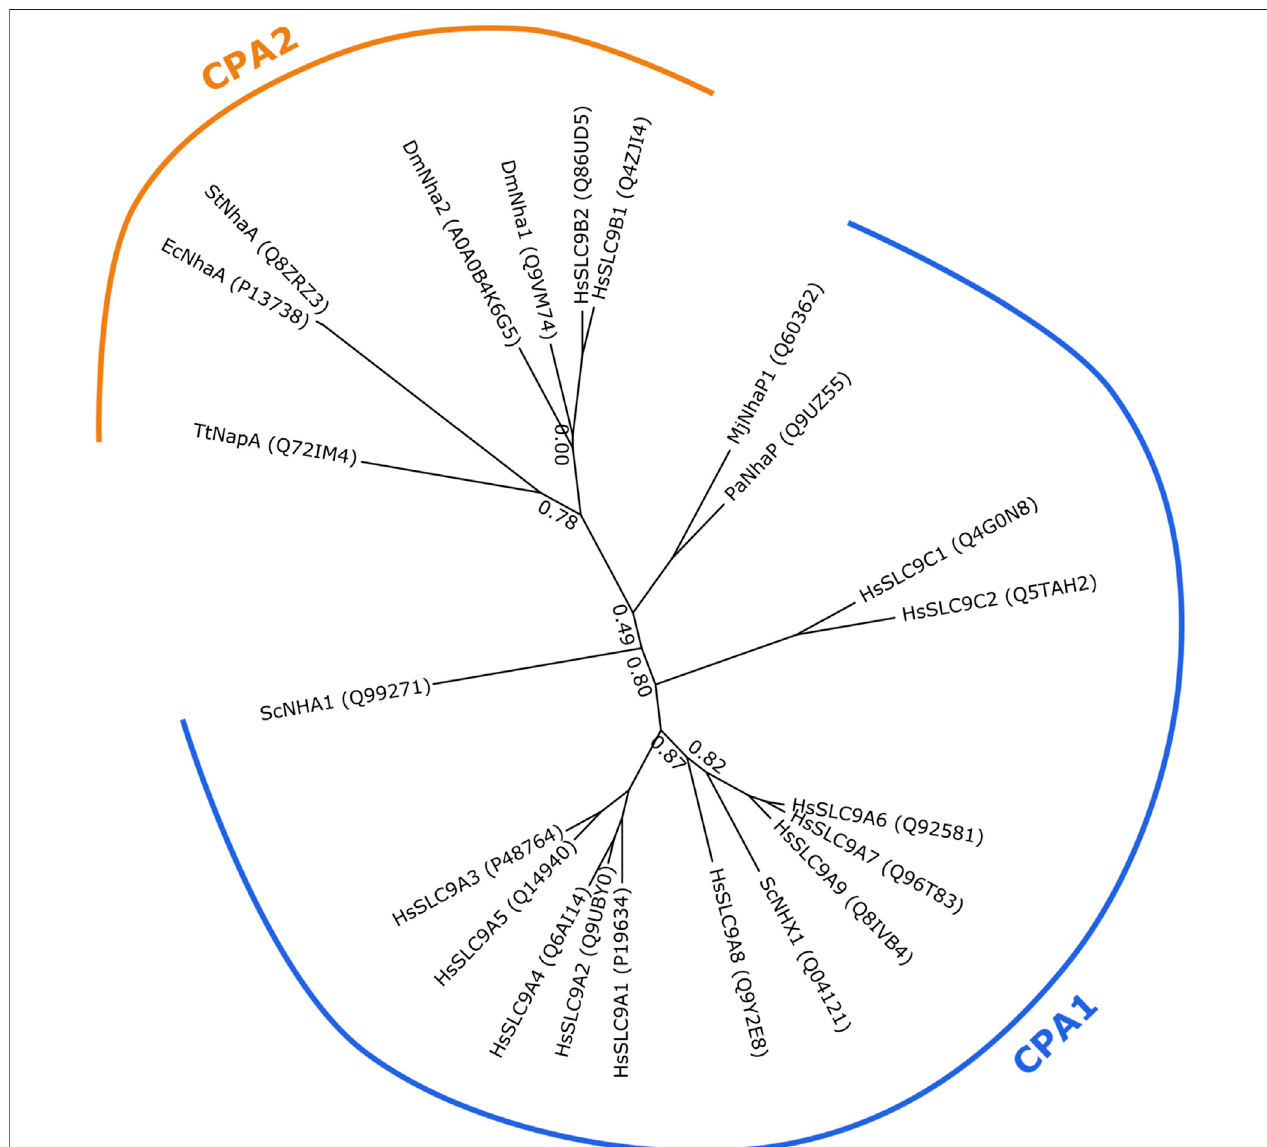
FIGURE 1 | Phylogenetic tree showing evolutionary relatedness of Na + /H + exchangers of the CPA1 and CPA2 clades. Protein sequences of human SLC9 members and other Na + /H + exchangers of lower organisms with structural or functional relevance have been collected from UniProt (accession numbers shown in parentheses). Sequences were aligned using Clustal Omega 1.2.1 (Sievers et al., 2011; Sievers and Higgins, 2018) with fi ve iterations and defaultsettings. Smart Model Selection 1.8.4 (Lefort et al., 2017) and PhyML 3.3.20190909 (Guindon et al., 2010) were used to generate the phylogenetic trees, with 10 random starting trees and using the approximate likelihood ratio test aLRT method (Anisimova and Gascuel, 2006). The tree was visualized using TreeViewer 2.0.1 (https://treeviewer.org/). Branch support values below 0.9 are shown. CPA1 and CPA2 clades are marked. Dm, Drosophila melanogaster ; Ec, Escherichia coli ; Hs, Homo sapiens ;